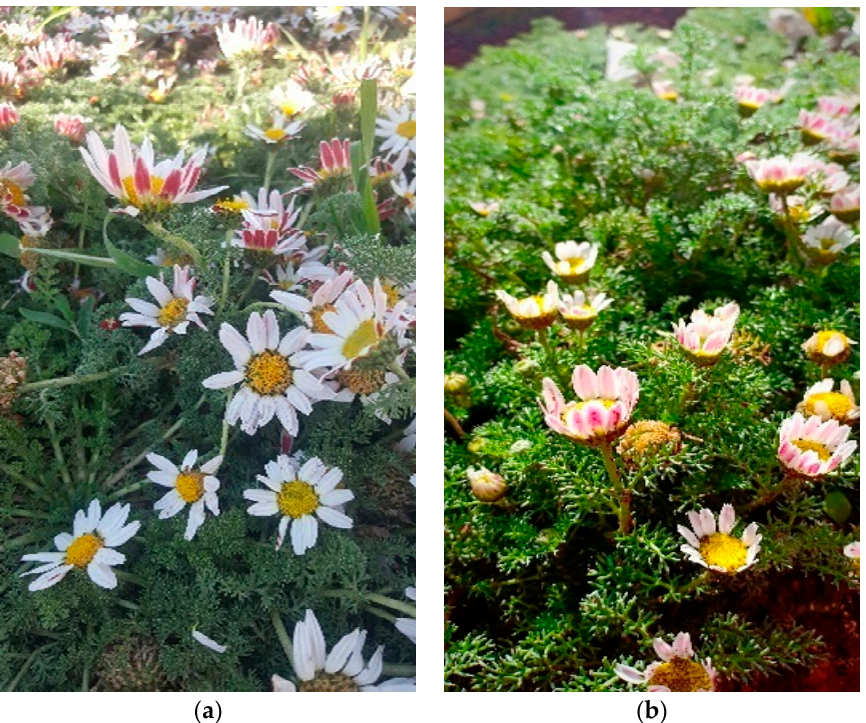
Figure 3. ( a ): Anacyclus pyrethrum var. pyrethrum (L.); ( b ) : Anacyclus pyrethrum var. depressus (Ball) Maire .